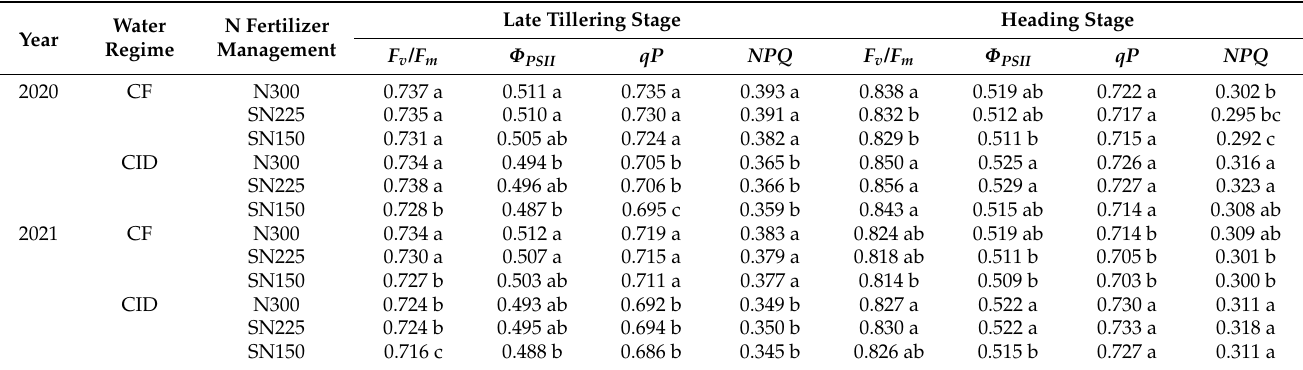
Table 2. PSII photochemistry ( Φ PSII ), maximum efficiency of PSII photochemistry ( Fv / Fm ), photo- chemical quenching coefficient ( qP ) and nonphotochemical quenching coefficient ( NPQ ) in the flag leaves of Nanjing9108 rice variety ( Oryza sativa L.) under various water and fertilizer